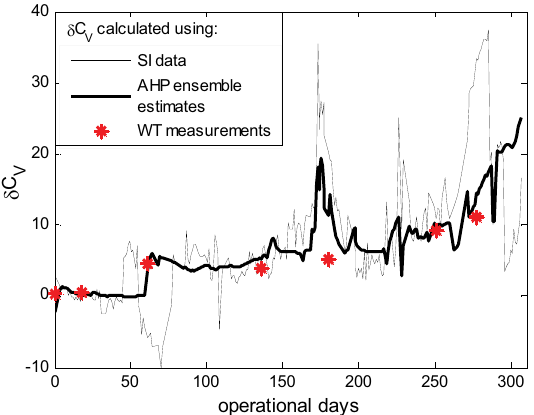
Table 9. Monotonicity r s of the health indicator calculated using the SI dataset, the individual models estimates and those of the SM and AHP ensembles Method for mass flow rate estimation